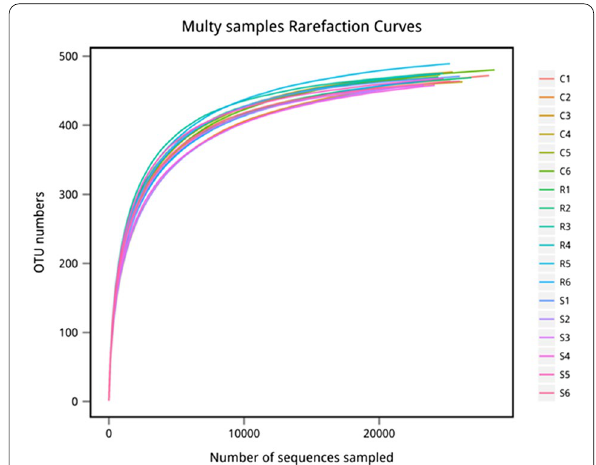
in CSM, R1-R6 indicated samples in RSM, S1-S6 indicated samples in SBM.)